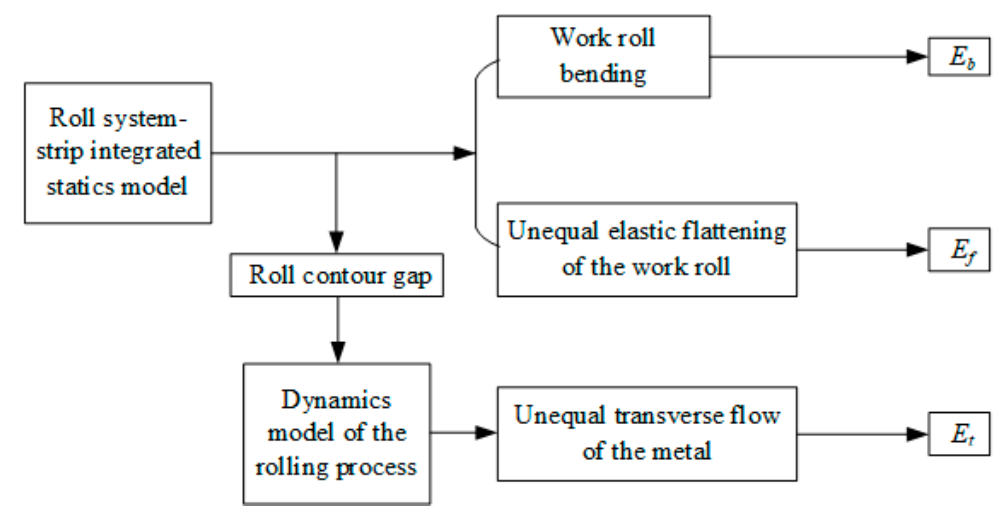
Figure 5. The method of calculating the edge drop E b , E f , and E t .